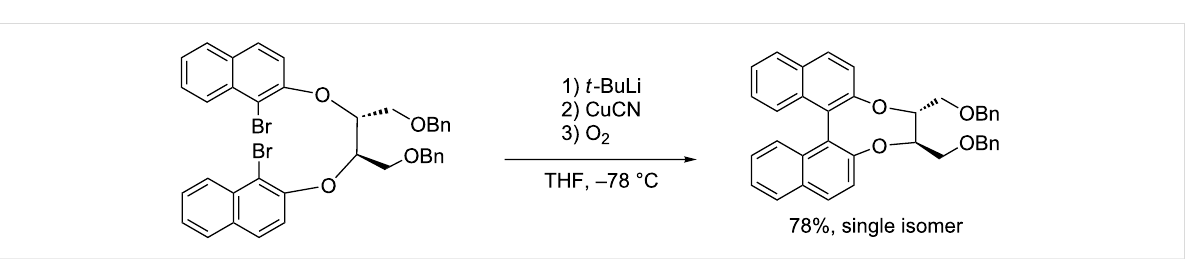
Scheme 11: Intramolecular coupling with chiral